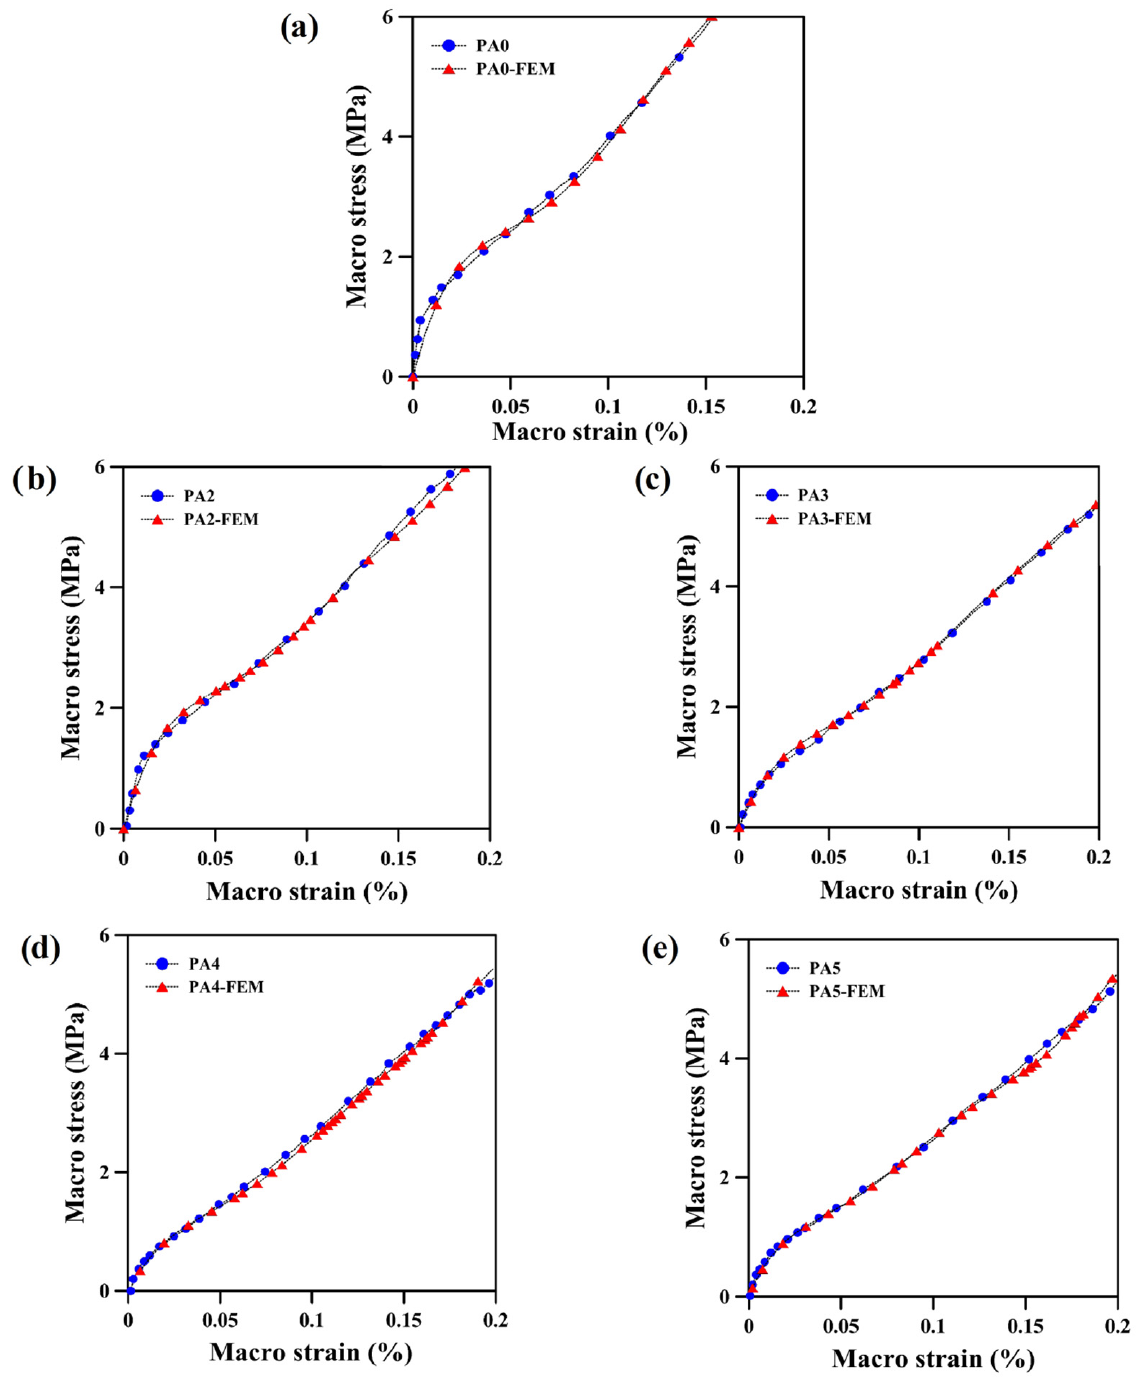
Figure 10. Macroscopic stress–strain behavior of: ( a ) unfoamed and foamed POE with different ADC contents: ( b ) 2 phr, ( c ) 3 phr, ( d ) 4 phr and ( e ) 5 phr.